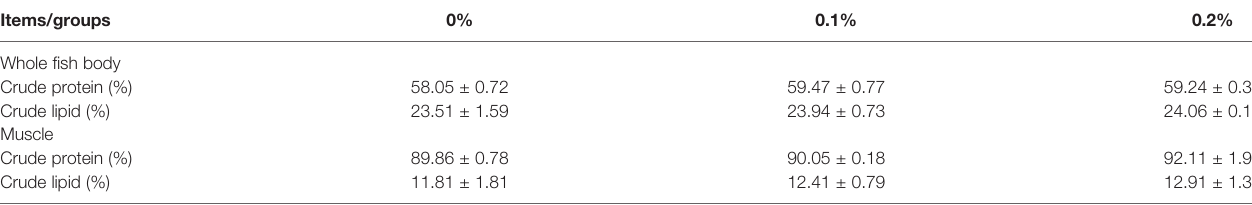
TABLE 4 | Whole-body and muscle composition of largemouth bass fed different experimental diets for 60 days. Items/groups